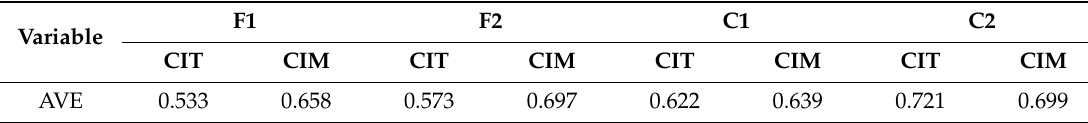
Table 19. Validity test of the questionnaire responses.